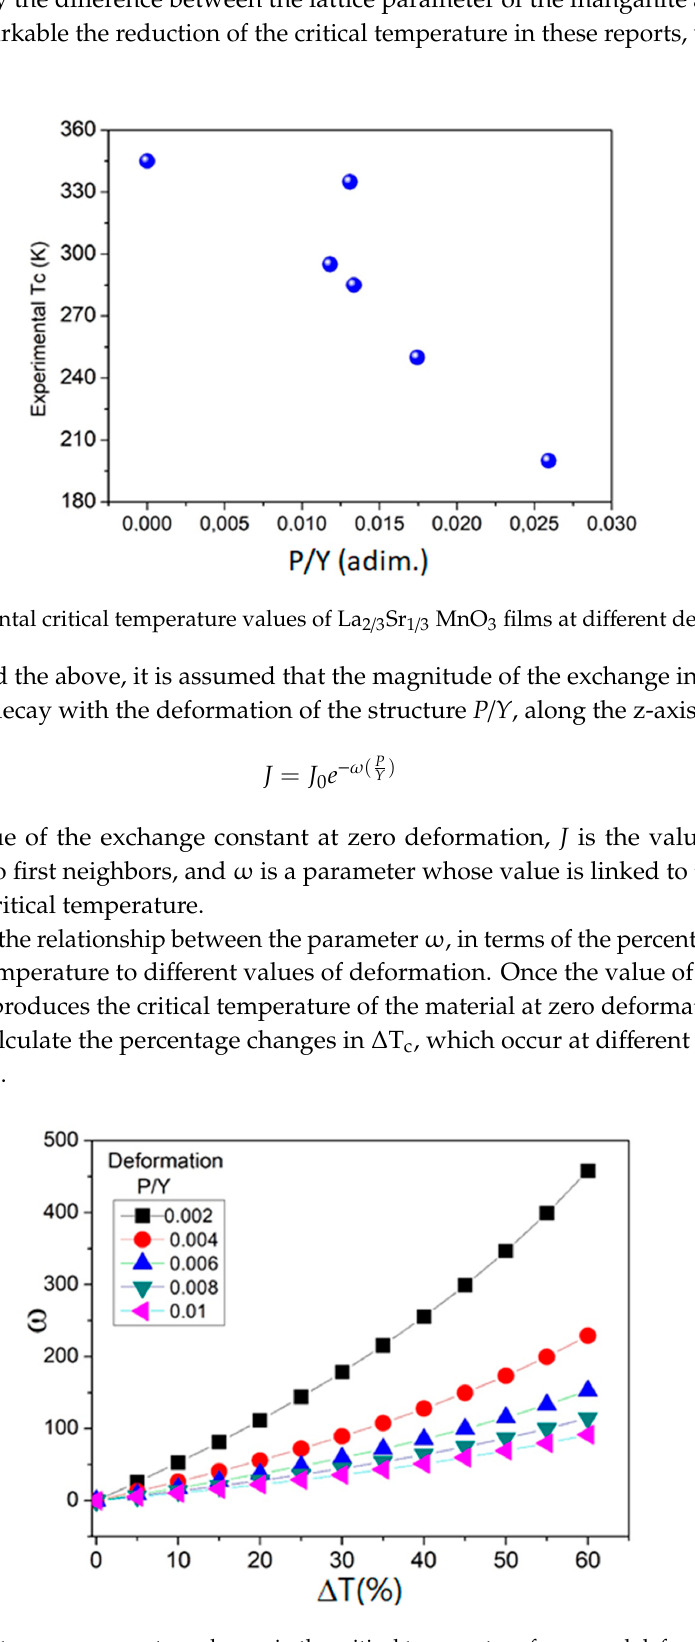
Figure 2. Parameter ω vs. percentage change in the critical temperature for several deformation values .